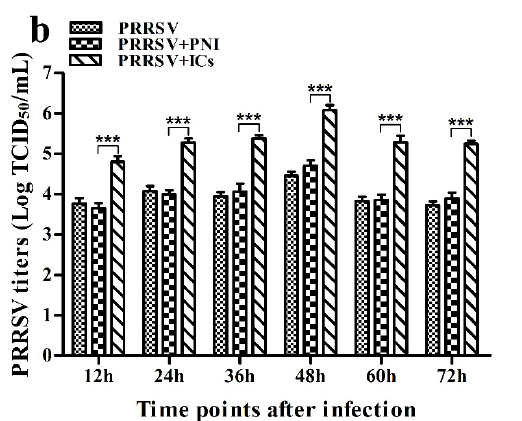
Figure 1. Effect of porcine IgG specific for PRRSV on PRRSV replication in porcine AMs. ( a ) Real-time RT-PCR analysis of PRRSV RNA copies in culture supernatants of cells infected with PRRSV, PRRSV + PNI or PRRSV + ICs. ( b ) PRRSV titers in culture supernatants of cells infected with PRRSV, PRRSV + PNI or PRRSV + ICs were measured in Marc-145 cells and expressed as TCID 50 / mL. *** p < 0.001. Note: PRRSV + PNI: PRRSV + porcine-negative IgG; PRRSV + ICs: PRRSV + porcine IgG against